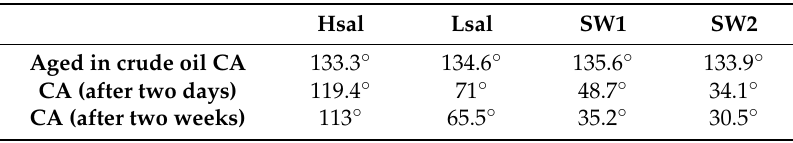
Table 7. Contact Angle values of Case 5 (strongly oil wet) calcite surfaces in crude oil and treated with brines for two days and two weeks.